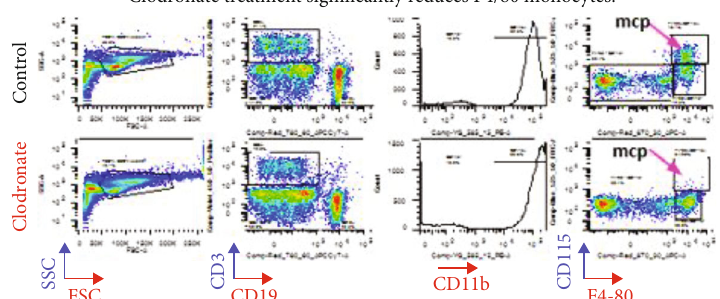
Figure 3: Supplemental data. Given are the fl ow cytometry pro fi les of F4/80+ monocytes from the control and clodronate-treated mice. F4/ 80+ cells are signi fi cantly reduced reaching less than 10% by clodronate treatment. Each time point n = 6